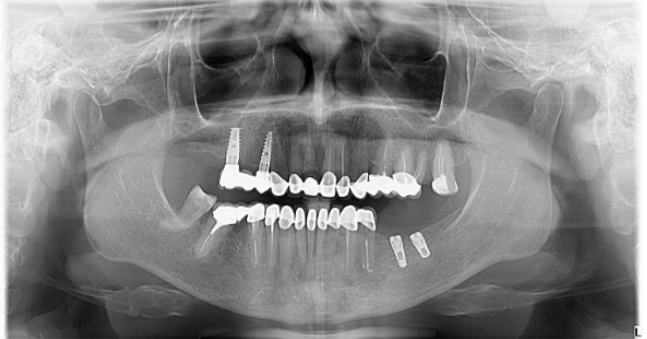
Figure 9. The sequences of the implant-prosthodontic therapy in the maxilla: ( a ) The emergence profile after the removal of the healing caps; ( b ) The impression copings in the mouth; ( c ) The transfer caps applied on the impression copings; ( d ) The master cast with the artificial gingiva and titanium abutments; ( e ) The zirconia frame on the master cast; ( f ) The intraoral try-in of the titanium abutments; ( g ) The intraoral try-in of the zirconia frame; ( h ) The final restoration after the intraoral fixation.